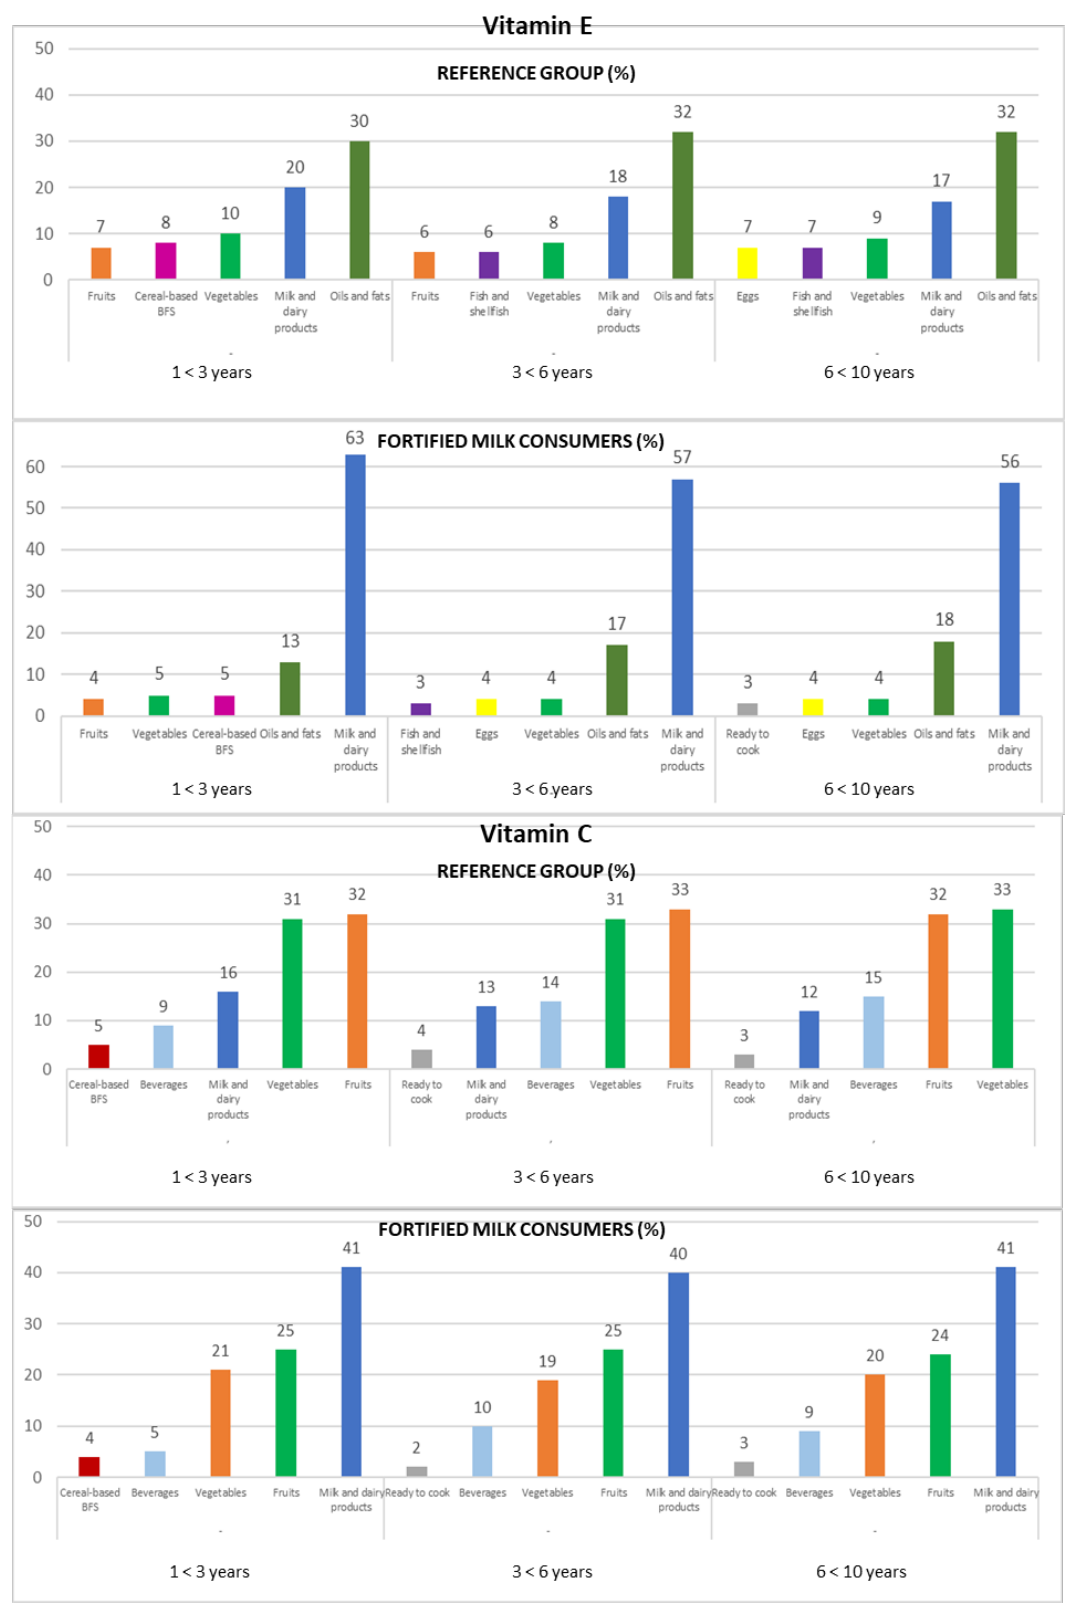
Figure 3. Contribution of the main five food groups (in percentages) to total vitamin E and C intakes in the EsNuPI study subpopulations according to age group: 1 to <3 years, 3 to <6 years, and 6 to <10 years. Cereal-based baby food and supplements (cereal-based BFS).